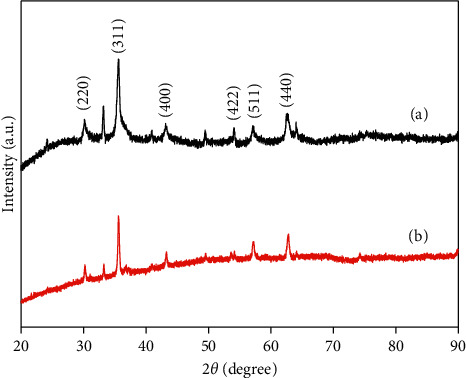
XRD patterns of CoFe2O4@SiO2. (a) and CoFe2O4 (b).